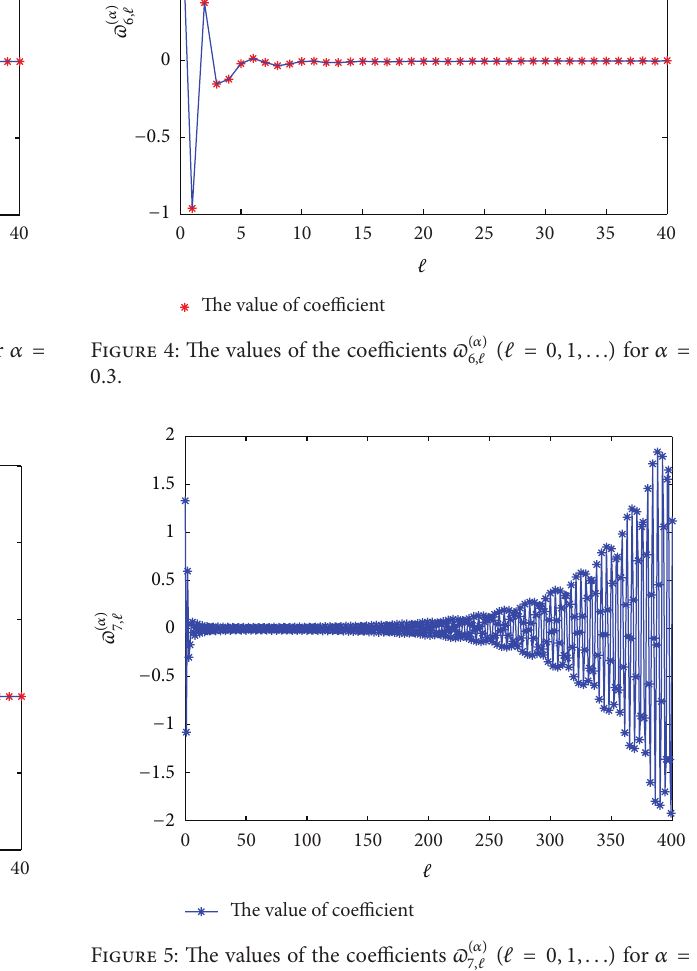
Figure 3: The values of the coefficients 𝜛 (𝛼) 5,ℓ (ℓ = 0, 1, . . .) for 𝛼 = 0.3 .